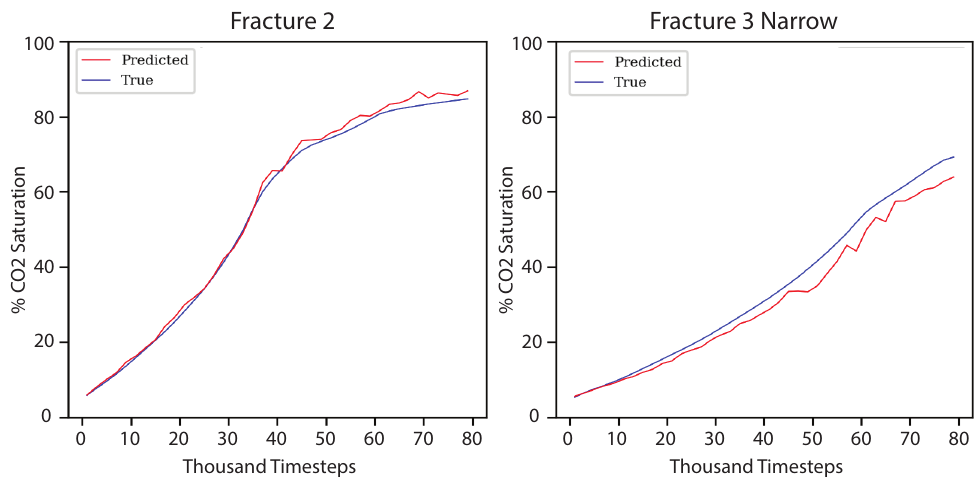
Figure 8. Saturation profiles through time comparing the simulation’s CO 2 saturation to the ML prediction in Fracture 2 ( left ) and Fracture 3 Narrow ( right ).